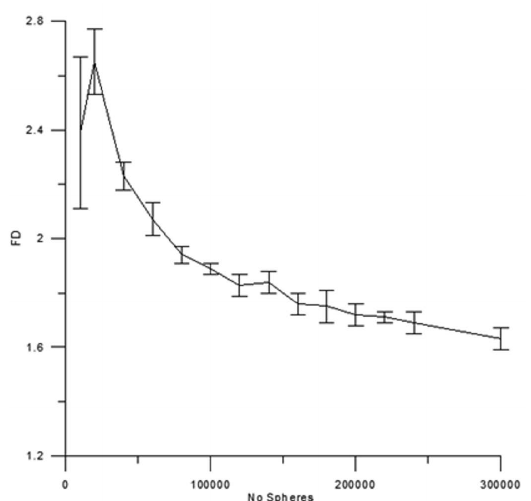
Fig. 1i. Fractal dimension obtained as a function of the number of randomly located buried sphere sources of mass 10 11 kg, at a depth of 5m. Because the fractal dimension depended on the locations of the spheres and these were determined randomly, the calculations were repeated five times and the mean value and the standard devi- ation